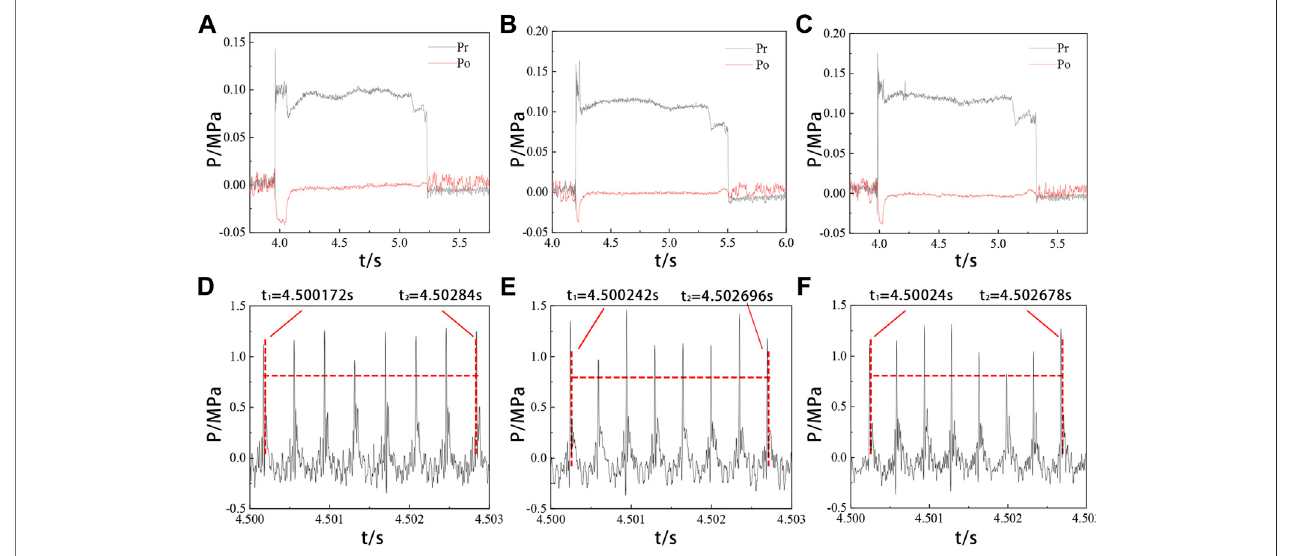
FIGURE 13 | Results of operating at φ (cid:1) 0 . 987 ， φ (cid:1) 1 . 086 ， φ (cid:1) 1 . 152. (A) — (C) Static pressure signals; (D) — (F) Local pressure signals.